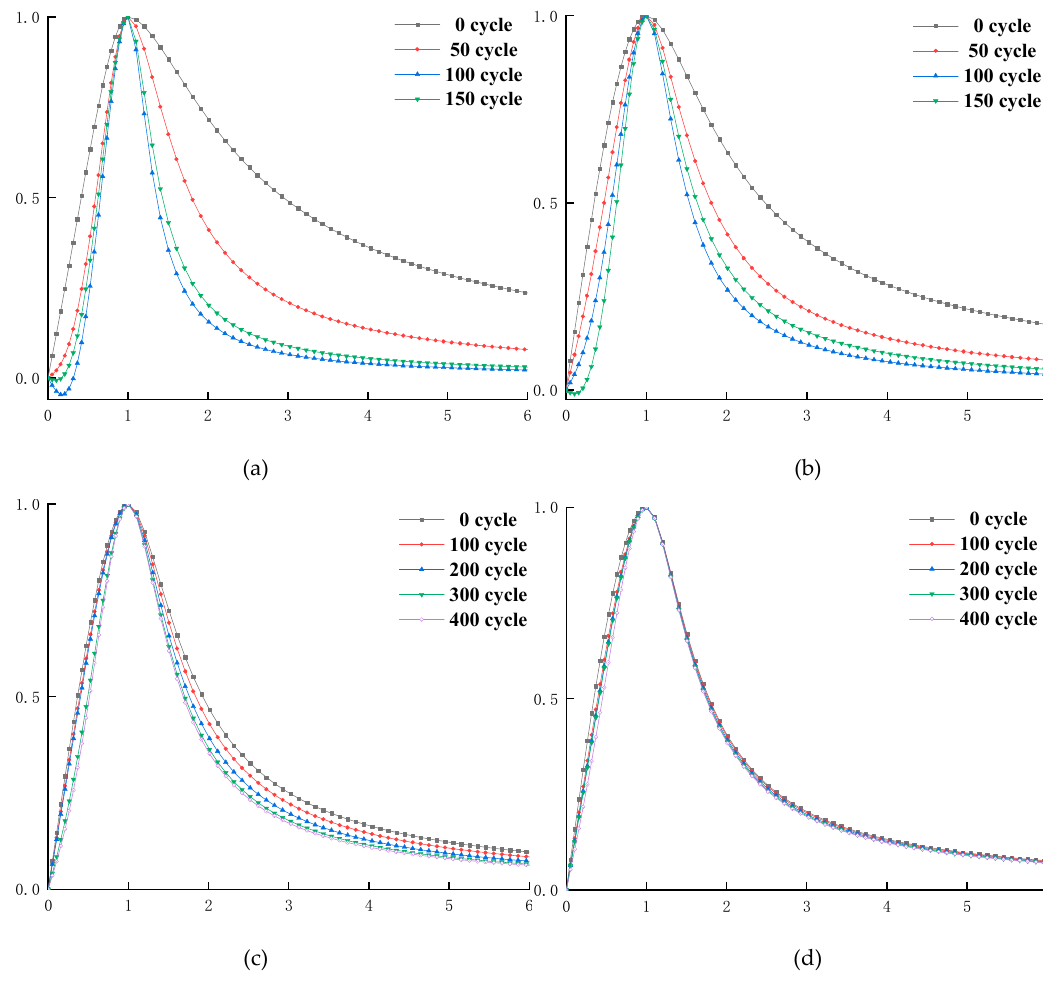
Figure 8. Dimensional fitting curve of stress–strain for freeze–thaw concrete under uniaxial compression: ( a ) O-C40 concrete; ( b ) O-C40 concrete; ( c ) AE-C40 concrete; and ( d ) AE-C40